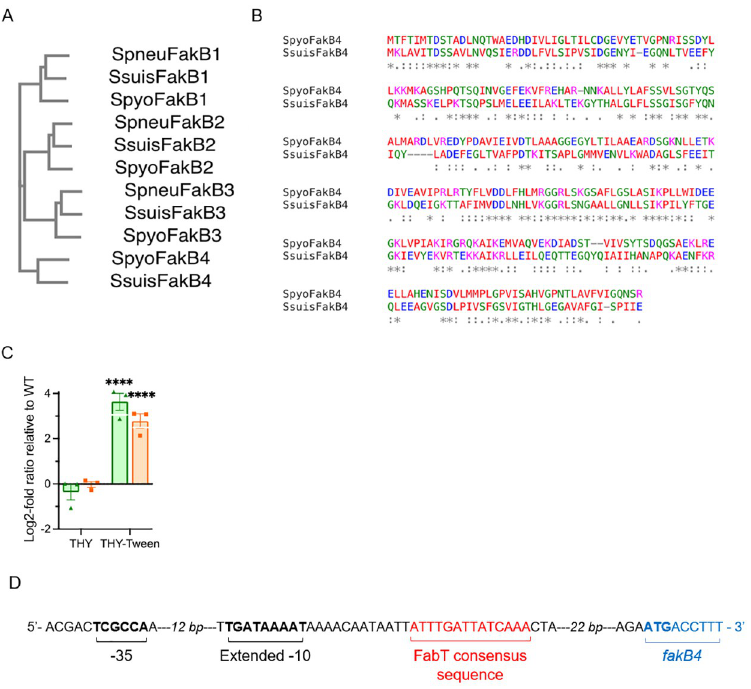
Fig 1. The M28_Spy1638 gene encodes a FakB4 protein and belongs to the FabT regulon. A) Phylogenetic tree of the three S . pneumoniae (Spneu), four S . suis (Ssuis), three S . pyogenes (Spyo), FakB proteins and the M28_Spy1638 product, named FakB4; the branch lengths are, from top to bottom, 0.17461, 0.15163, 0.20011, 0.13539, 0.13176, 0.17447, 0.15335, 0.1527, 0.18335, 0.22949, 0.21848. B) Sequence comparison of S . pyogenes and S . suis FakB4 proteins. C) Relative expression of fabT , green, and fakB4 orange, in the mFabT versus the WT strain. Strains were grown in THY or THY-Tween 80 medium and RNAs were quantified by qRT-PCR. Expression was normalized to that of gyrA ; relative gene expression is expressed as the log2-fold ratio in the mFabT versus the WT strain. 2-way ANOVA, Bonferroni post-test, **** p < 0.0001. D) Cartoon representing the regulatory region of the fakB4 gene with -35 and extended -10 boxes, previously published [18], FabT consensus sequence and fakB4 translation initiation site indicated in black, red and blue, respectively.